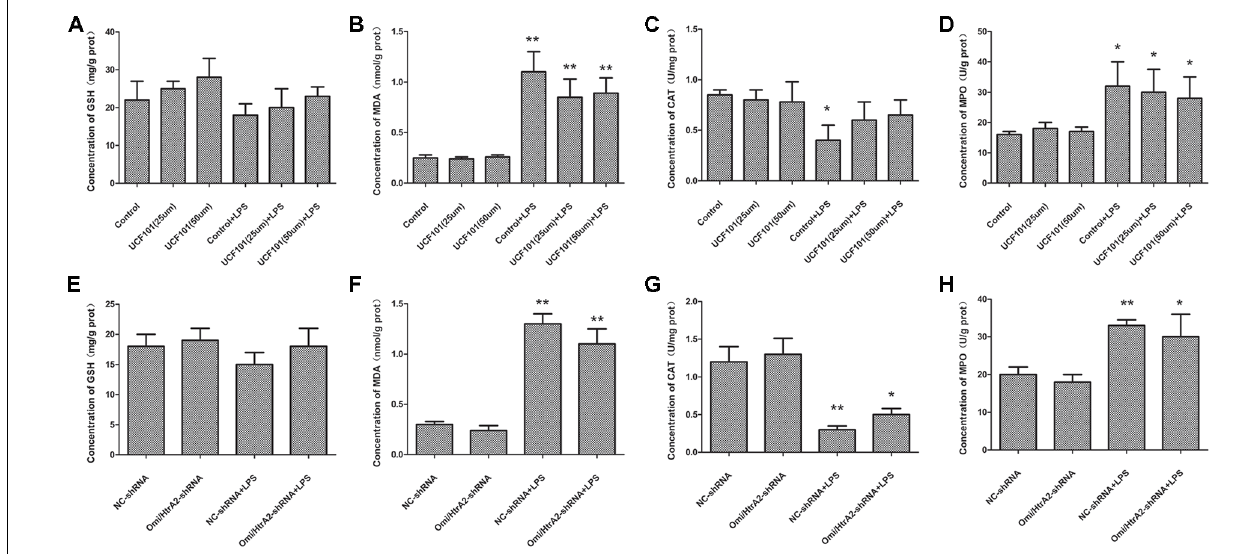
FIGURE 10 | Oxidative stress did not play a key role in alleviating apoptosis by Omi/HtrA2 intervention. (A–D) Effects of Omi/HtrA2 inhibition by UCF-101 or (E–H) Omi/HtrA2 shRNA on GSH, malondialdehyde (MDA), catalase (CAT) and myeloperoxidase (MPO) levels in LPS-treated hCMEC/D3 monolayers. ∗ P < 0.05, vs. control or NC-shRNA, ∗∗ P < 0.01, vs. control or